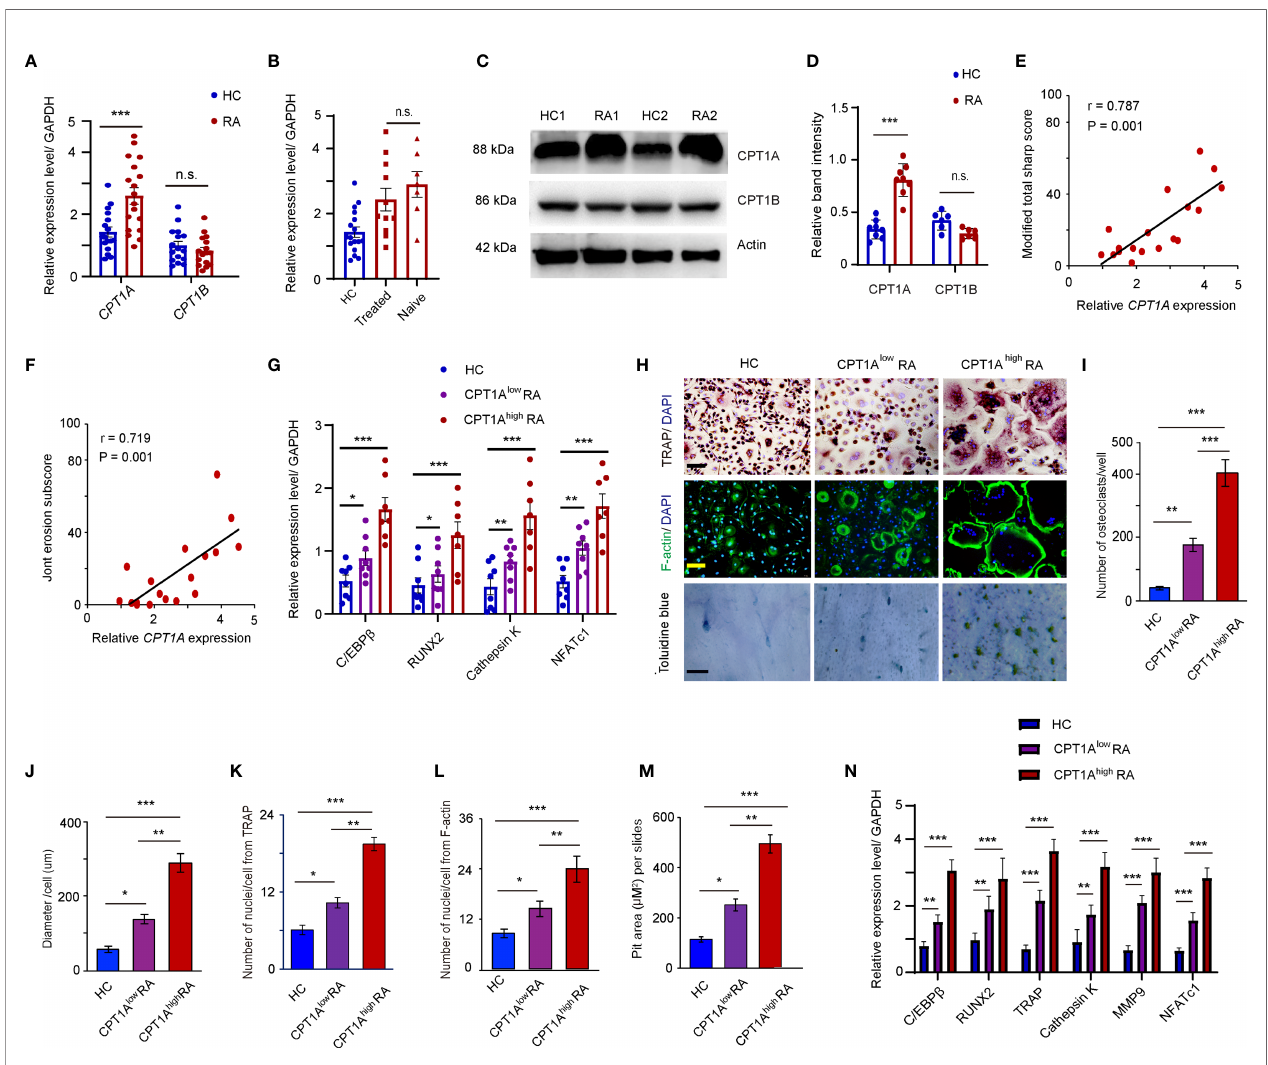
FIGURE 2 | Enhanced CPT1A expression in OCPs promotes osteoclast formation and cell-cell fusion. CD14 + monocytes were isolated from HCs and RA patients. (A) CPT1A and CPT1B gene expression was quanti fi ed by qPCR in monocytes from HCs and RA patients. The results from 3 independent experiments involving 18 RA patients and 17 HCs are shown as scatter plots. (B) Higher expression of CPT1A is independent of drug treatment (treated vs. treatment naïve). (C – D) Representative blotting for CPT1A and CPT1B protein expression. The band intensities were adjusted to actin. Results analyzing 5 RA patients and 5 HCs are shown as the mean ± SEM at (D) . (E, F) CPT1A gene expression in 18 RA patients was assessed for correlation with the modi fi ed total Sharp score (E) , and erosion subscore (F) . (G – M) CD14 + monocytes from 17 healthy controls, 11 patients with lower CPT1A gene expression, and 7 patients with higher CPT1A gene expression were cultured with RANKL and macrophage colony-stimulating factor (M-CSF). (G) Transcript levels of C/EBP b , RUNX2 , Cathepsin K , and NFATc1 at day 0 were quanti fi ed by qPCR in HC, CPT1A low RA, and CPT1A high RA groups. (H) Mature osteoclasts were detected by tartrate-resistant acid phosphatase (TRAP) staining on day 21, bar 100 m m; and FITC – phalloidin staining on day 21, bar 100 m m. Bone resorption activity of osteoclasts was detected by toluidine blue staining on day 21. bar 50 m m. Representative results are shown. (I) Cell counts of mature osteoclasts from 24-well plates on day 21. (J) The sizes of the osteoclasts were obtained by measuring the diameters of multinucleated TRAP-positive cells. (K) Mean nuclei number of multinucleated TRAP-positive cells. (L) Mean nuclei number of multinucleated F-actin positive cells. (M) Pit area of bone resorption lacunae. (N) Transcript levels of C/EBP b , RUNX2 , TRAP , Cathepsin K , MMP9 , and NFATc1 were quanti fi ed by qPCR in HC, CPT1A low RA, and CPT1A high RA groups. All data was presented as the mean ± SEM. * P < 0.05; ** P < 0.01; *** P < 0.001; n.s. no signi fi